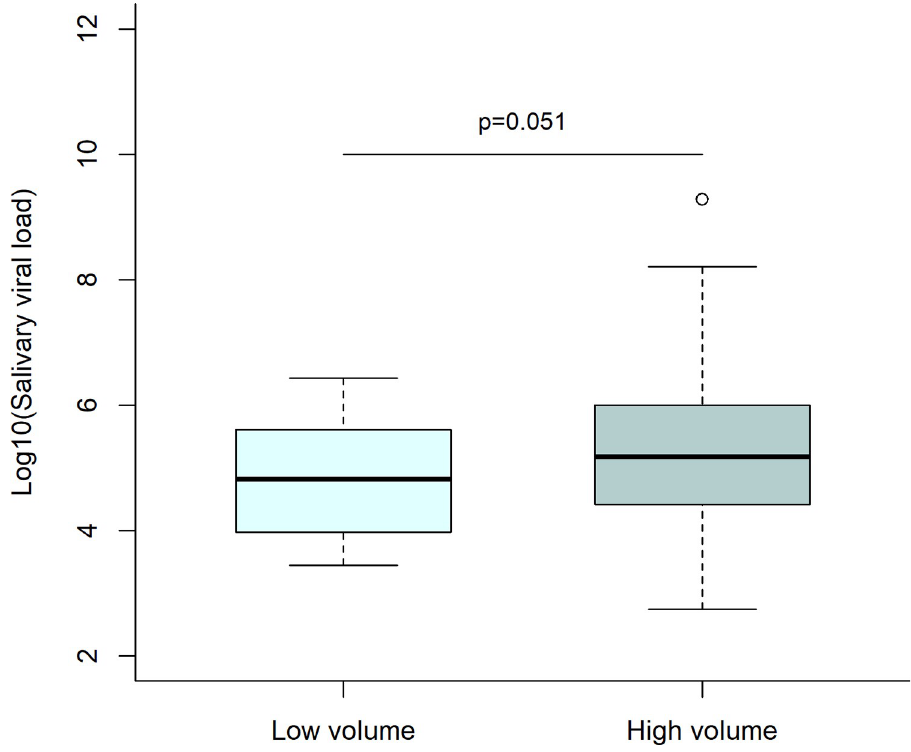
Fig 9. Log viral loads by saliva PCR saliva volume: Low volume corresponds to a gingivo-buccal swab only; high volume corresponds to a gingivo-buccal swab with < 0.5 ml of saliva in addition.